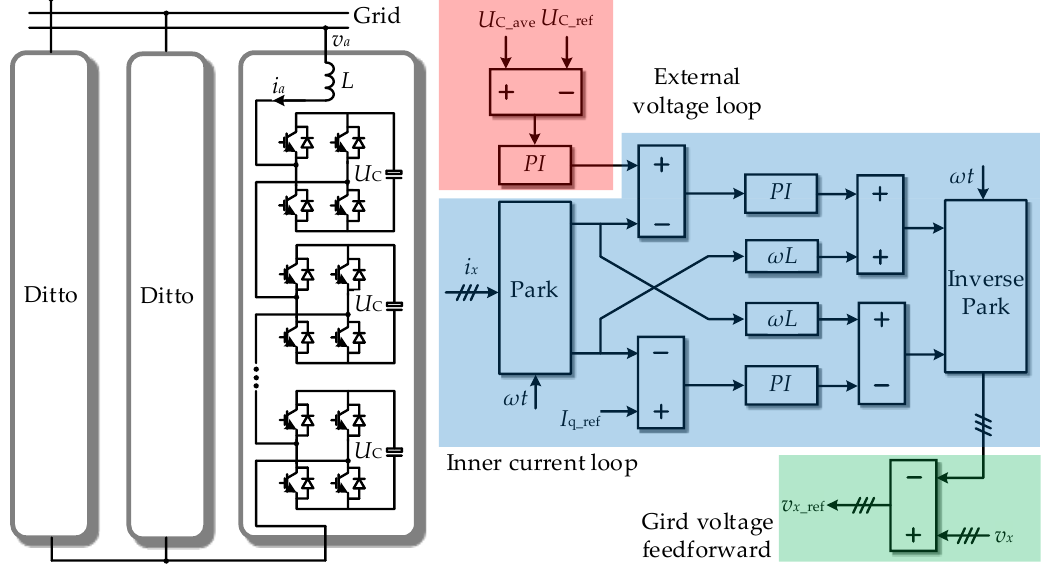
Figure 1. Configuration of star-connection the three-phase cascaded H-bridge static synchronous compensators (CHB-STATCOM) and schematic dual-loop control block diagram.